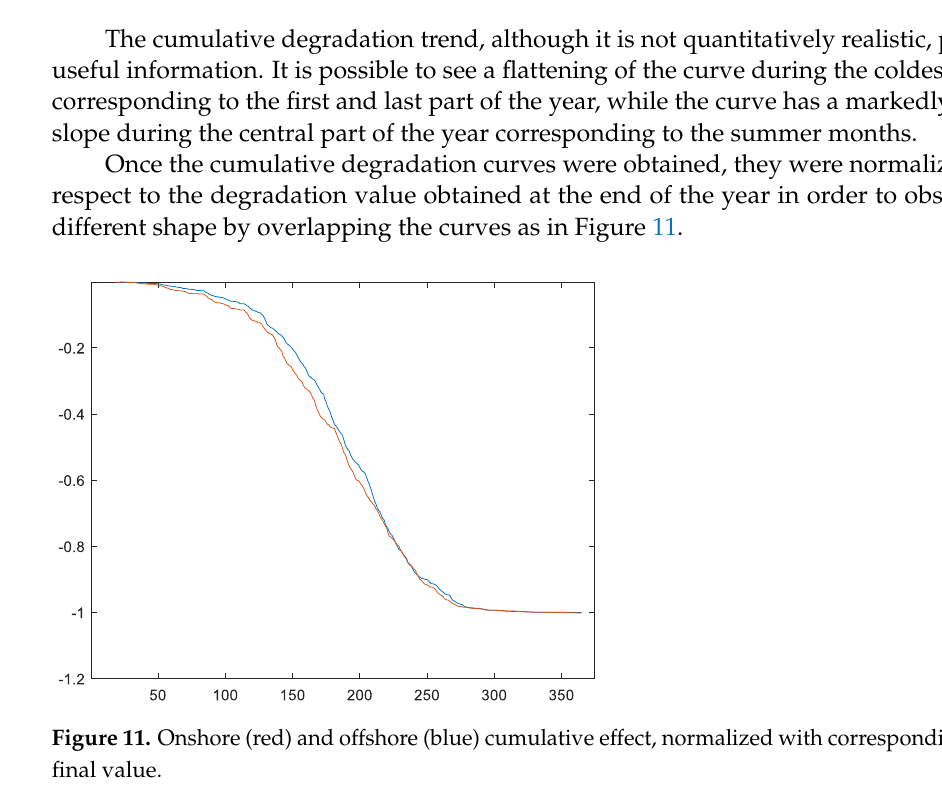
Figure 10. Offshore cumulative effect of environment on degradation over one year.